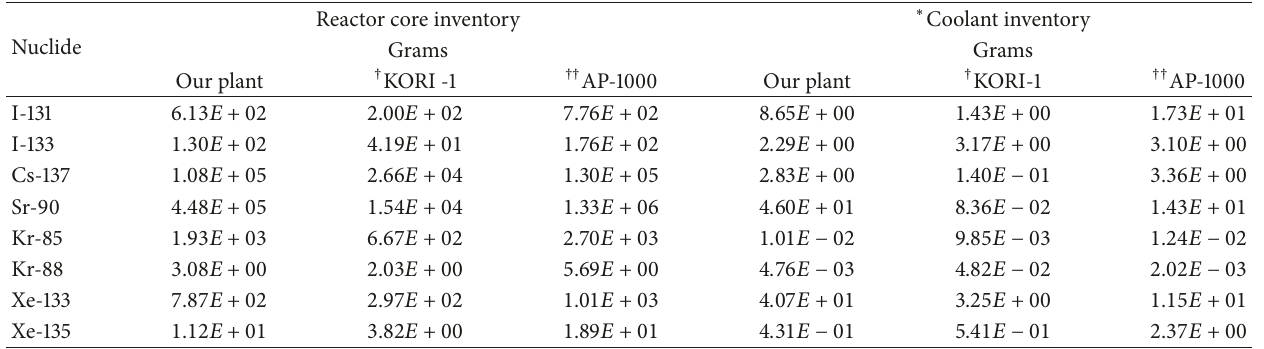
Table 5: Comparison of core and coolant inventory for selected isotopes.